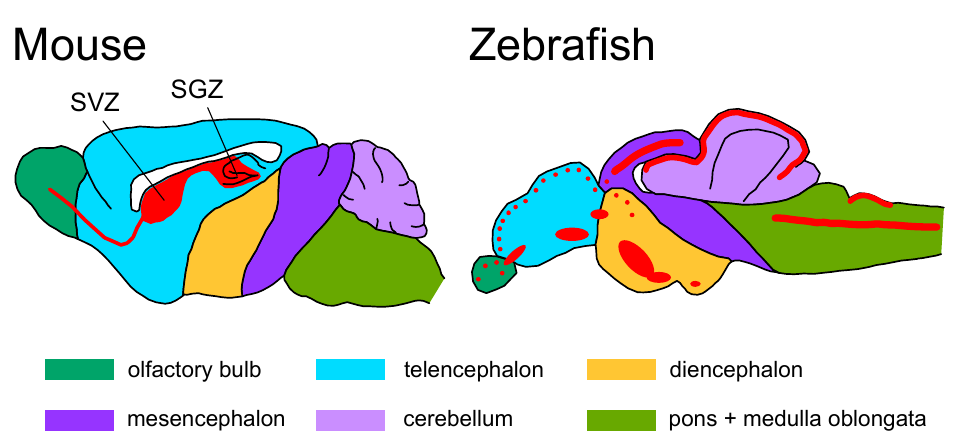
Figure 4. Progenitor cells (radial glial cells) distribution in the mouse and zebrafish brain. The red color indicates regions of constitutive proliferation. Based on the data summary from [295]. SVZ, subventricular zone; SGZ, dentate gyrus subgranular zone.